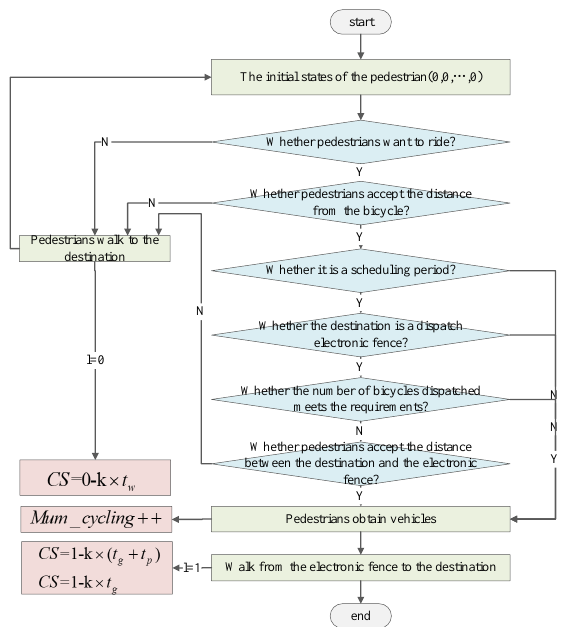
Figure 2. Scheduling process of a bike sharing system (BSS).